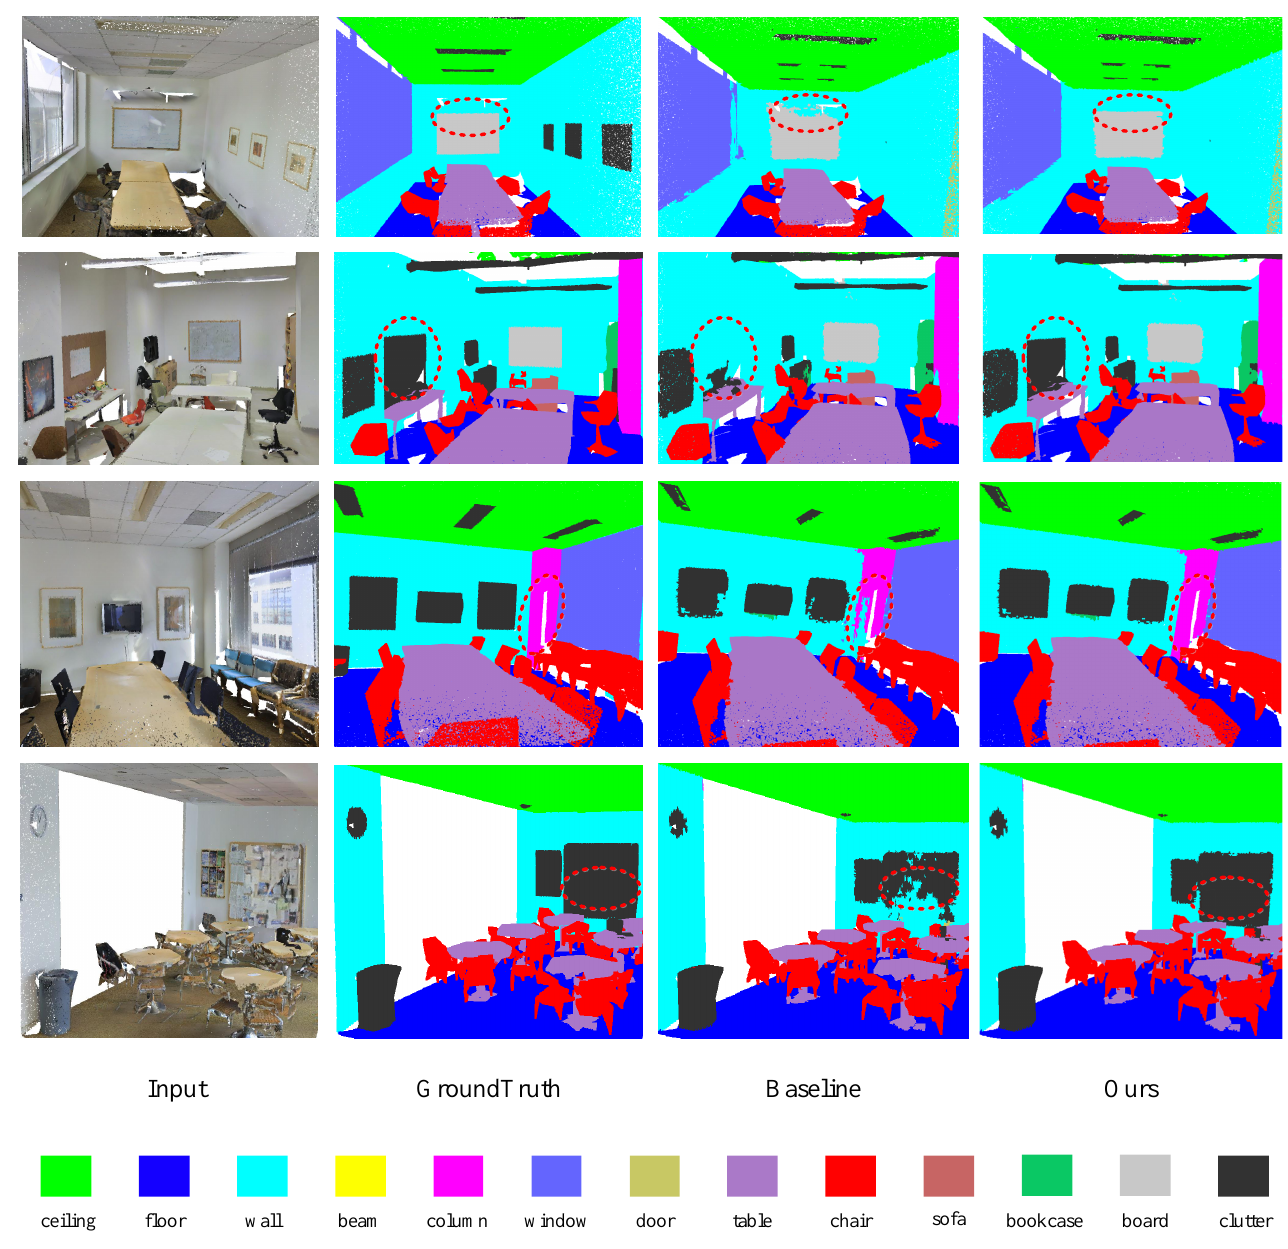
Figure 7. Qualitative comparison results on different scenes from S3DIS Area 5. Improvements on boundary regions are highlighted with red dashed circles. From left to right: the input raw point clouds, the ground-truth label, the baseline predicted results, and the predicted results of our method. The baseline represents the proposed model training from scratch, which denotes no pretraining process in the